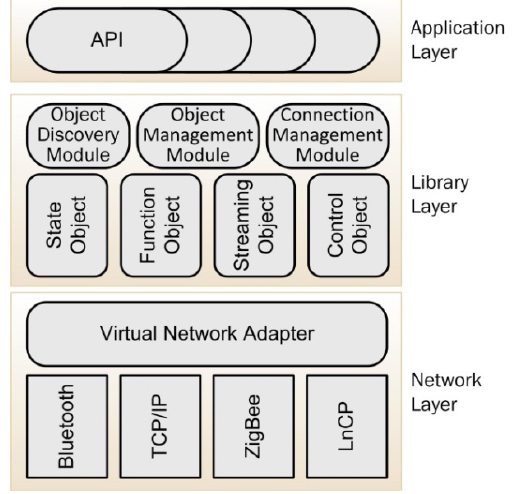
Figure 6. OHNet components, as described in [25].